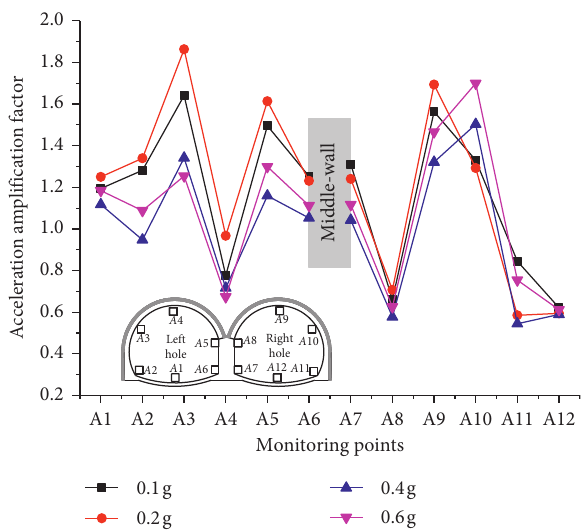
Figure 11: The difference between the horizontal AAF of WC-XZ and WC-X.